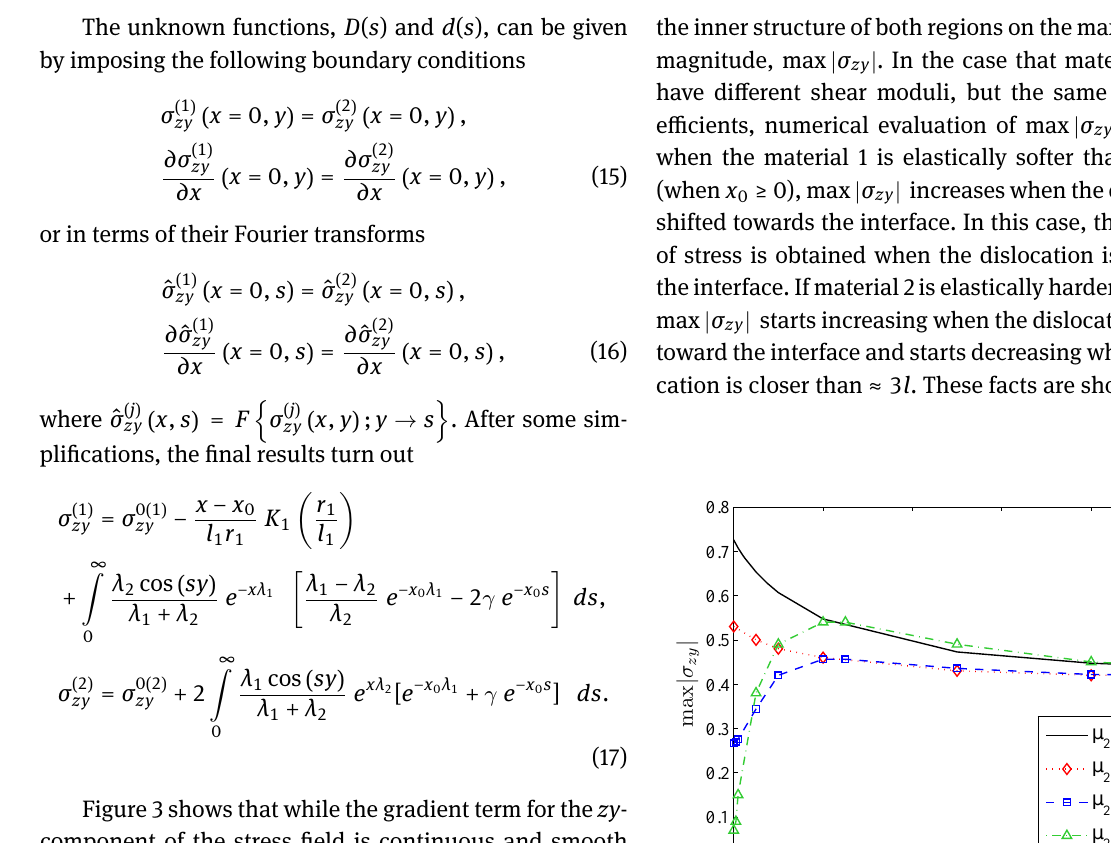
. The stress 2 / µ 1